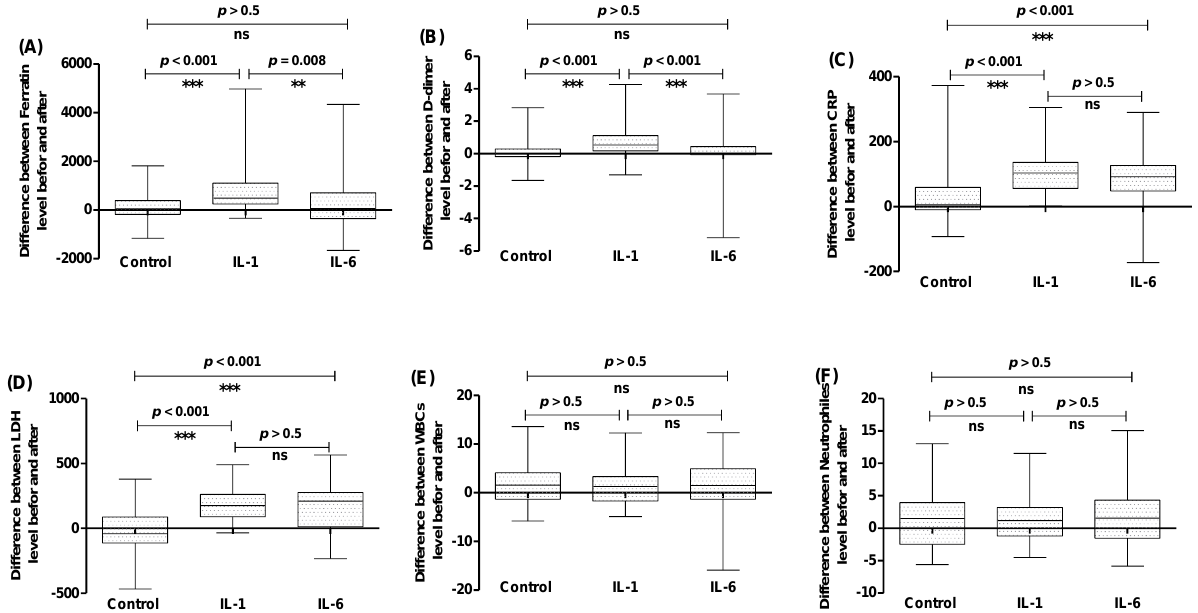
Figure 4. Comparison between the change in different parameter levels before and after adminis- tration of the treatment regimen without interleukin antagonists, or treatment regimens including IL − 1 or IL − 6 antagonists. The differences in levels of ( A ) ferritin, ( B ) D-dimer, ( C ) CRP, ( D ) LDH, ( E ) WBCs, and ( F ) neutrophiles were compared between the three treatment regimen. *** = p ≤ 0.001, ** = p < 0.01, and ns (nonsignificant) p > 0.05.